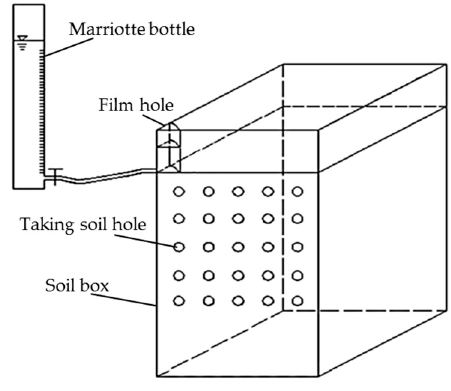
Figure 1. Experimental setup of film hole irrigation.